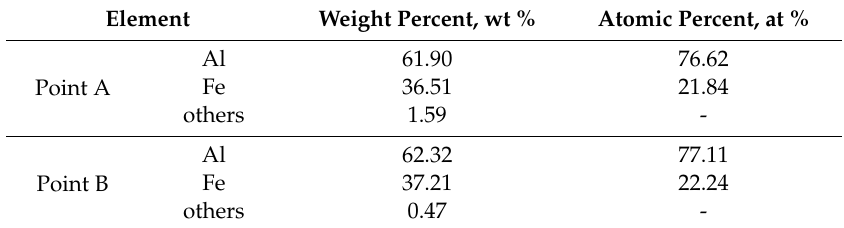
Figure 19. EDS analysis at point A. ( a ) SEM image; ( b ) Spectrum. Table 5. Elements in the interface layer.